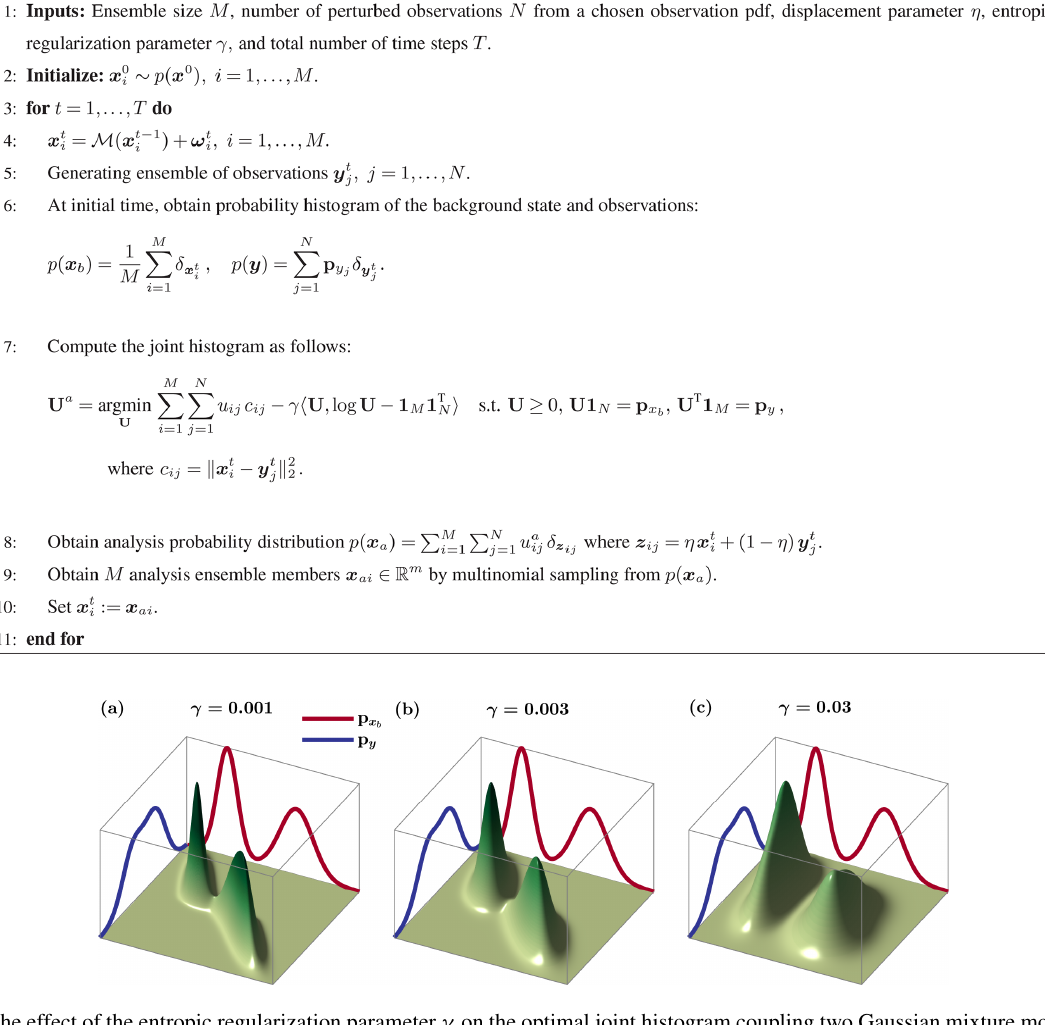
Figure 3. The effect of the entropic regularization parameter γ on the optimal joint histogram coupling two Gaussian mixture models, where p x is 0 . 5 N ( − 12 , 0 . 4 ) + 0 . 5 N ( − 8 , 0 . 8 ) and p y is 0 . 55 N ( 5 , 4 ) + 0 . 45 N ( 9 . 5 , 4 ) b